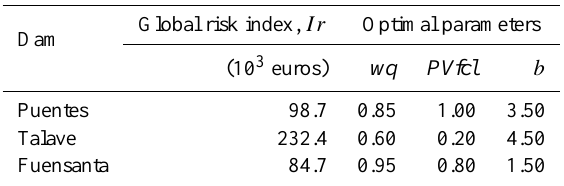
Figure 8 . Probability distribution of maximum release (left column) and maximum storage (right column) for: a) Puentes Dam, b) Talave Dam, and c) Fuensanta Dam. The optimal solution (black line) and the reference values ( kq and kv , dashed line) are shown. Table 3. Results of the calibration process, using the aggregated approach, represented by Ir .